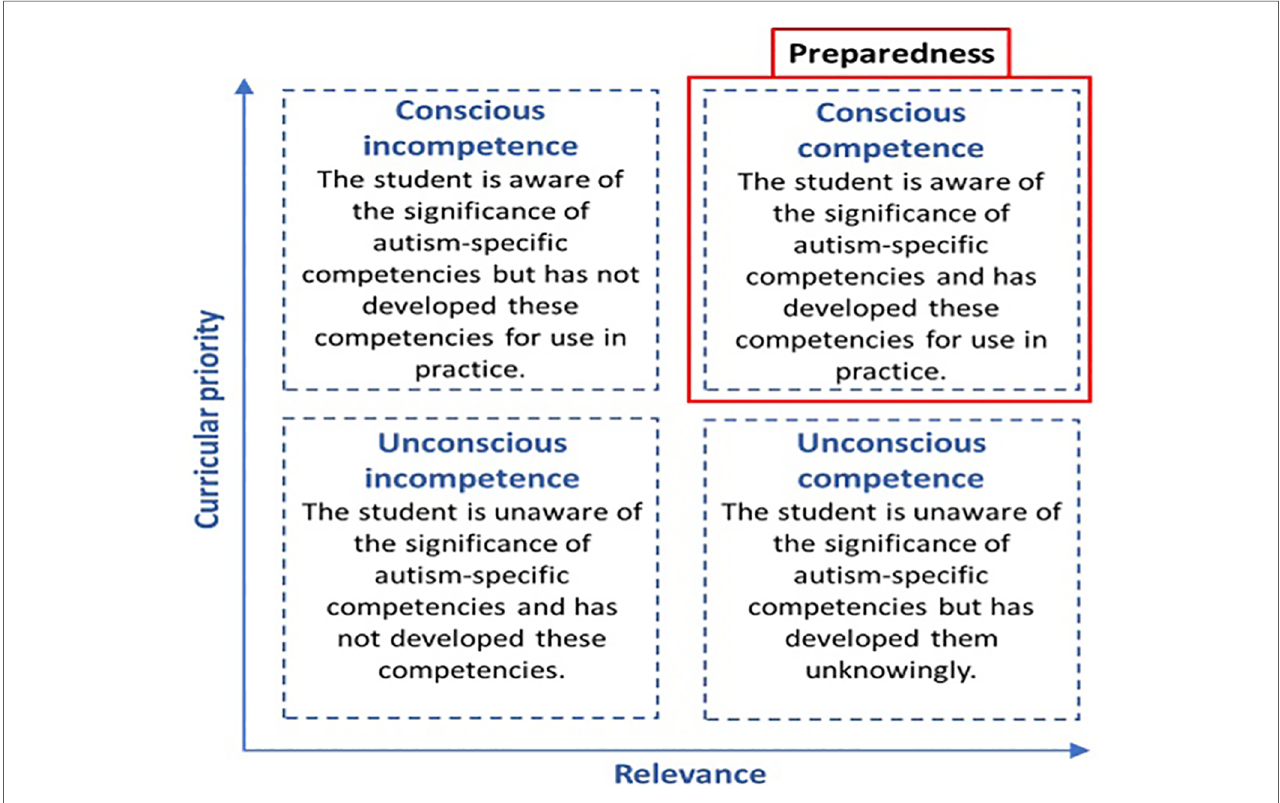
FIGURE 1 The contribution of curricular priority (conscious-provoking) and relevant (competency-driven) autism education of the development of